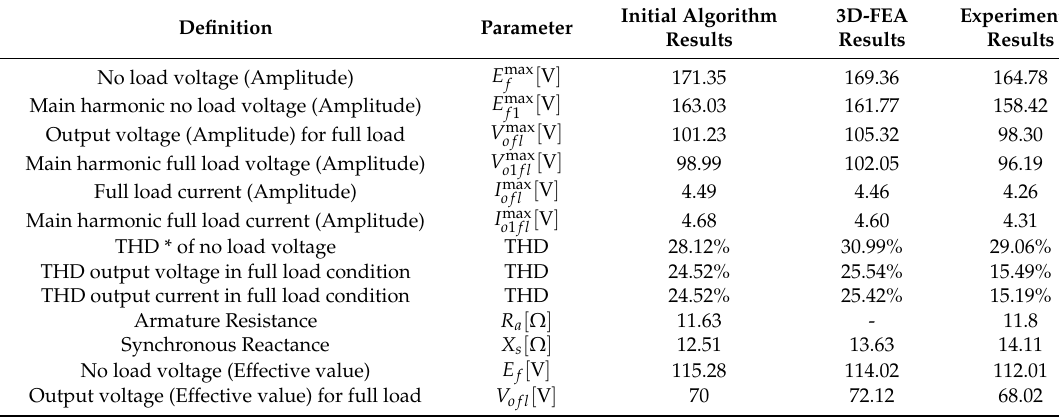
Table 6. Key motor parameters.